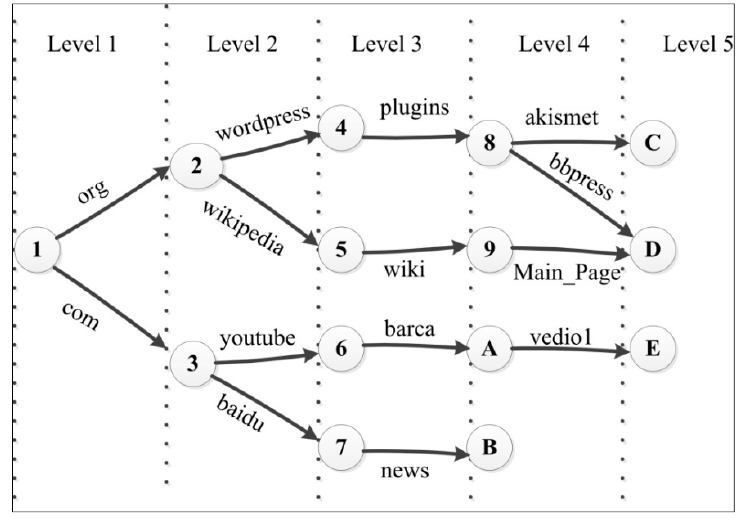
Figure3. AnExample of name prefix trie (NPT). Figure 3. An Example of name prefix trie